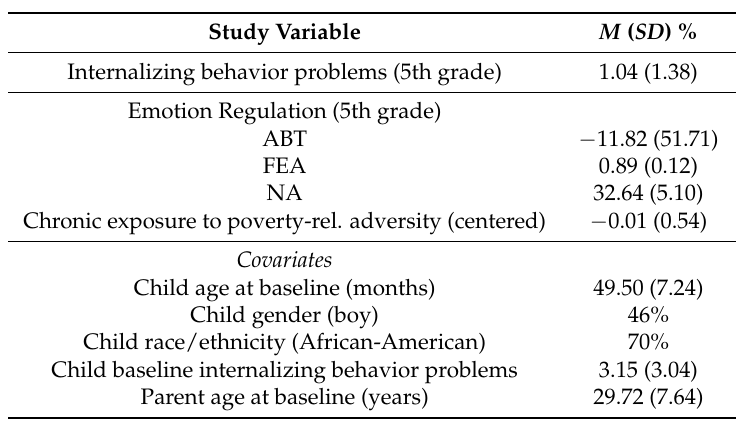
Table 1. Sample descriptive statistics ( n =